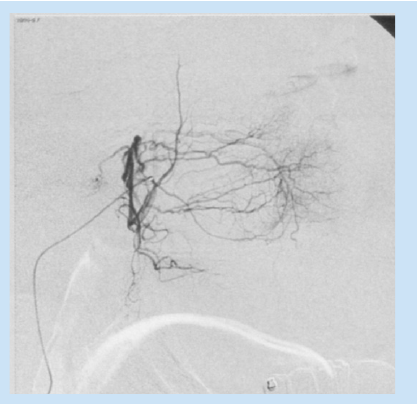
Fig 2b. Selective internal maxillary arteriogram (same case as Fig. 2a) showing the typical appearance of the nasal arteries prior to emboli- sation. No bleeding site is identifiable and the arteries have a normal appearance.